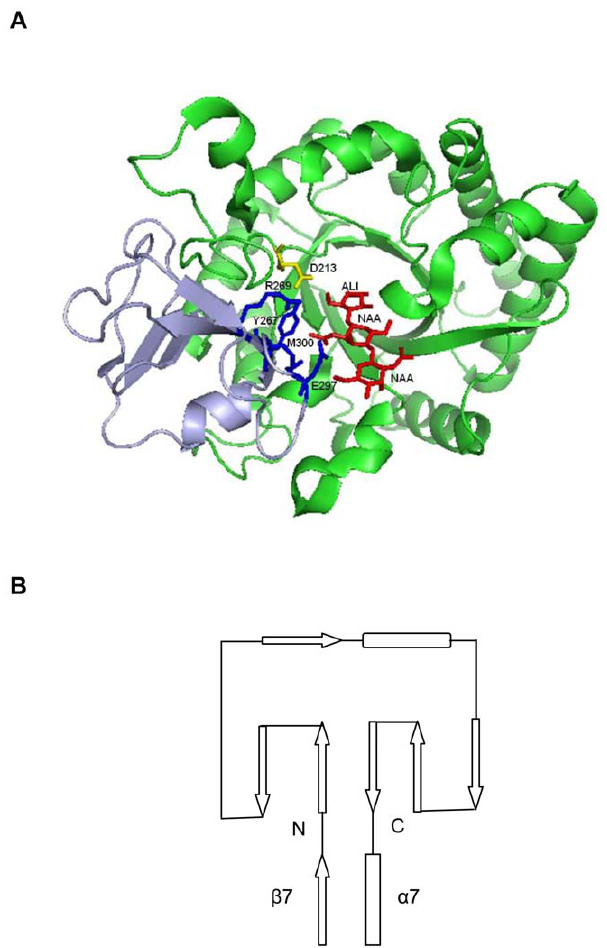
Figure 1. Structural analysis of the CID. (A) Ribbon model of human chitotriosidase (PDB: 1HKM) in complex with the substrate (NAA-NAA-ALI) generated by Pymol, showing the TIM barrel and CID. The helices and strands on the TIM barrel are coloured in green and those on the CID are coloured in light blue. Some residues (Tyr267, Arg269, Glu297, and Met300) in blue on the CID and Asp213 in yellow on the TIM barrel interact with the substrate in red. (B) Schematic representation of the CID between b 7 and a 7 on the TIM barrel, which is composed of two anti-parallel b -strands followed by one b -strand, one short a -helix, and lastly three anti-parallel b -strands. The arrows indicate b -strands and the rectangles are a -helices. The lines stand for the loops connecting a -helices or b